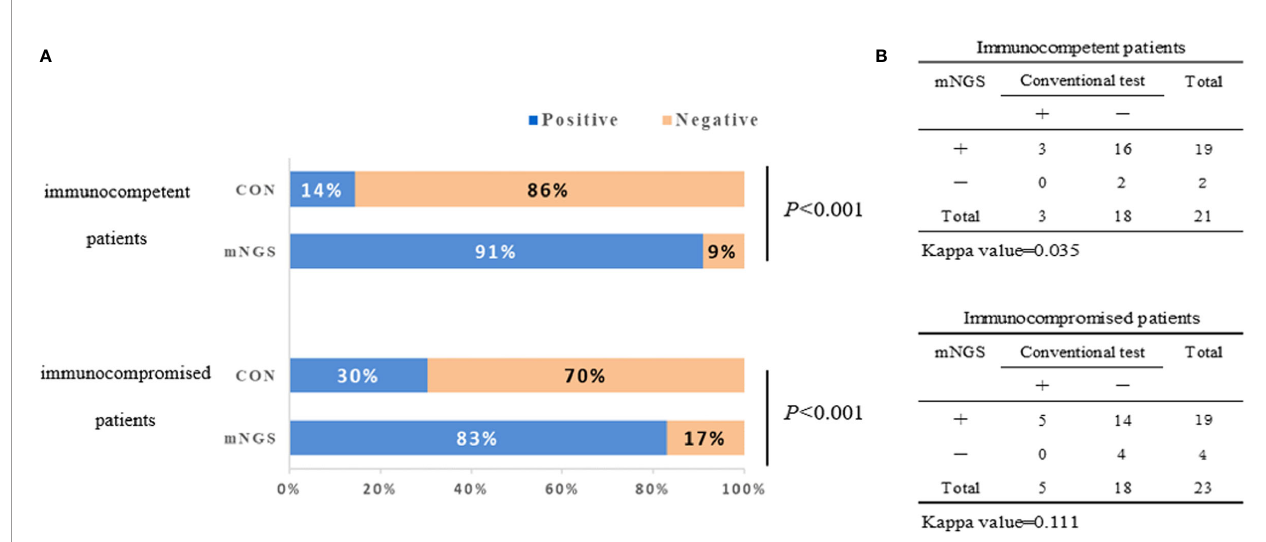
FIGURE 1 | The positivity rate comparison and concordance analysis between metagenomic next-generation sequencing (mNGS) and conventional test. (A) The comparisons of positive rates (X-axis) for pairwised mNGS and conventional test in immunocompetent patients and immunocompromised patients (Y-axis) ( P <0.001). (B) Concordance test showing there were low Kappa values of positive rates between mNGS and conventional test for both immunocompetent patients (0.035) and immunocompromised patients (0.111). mNGS, metagenomic next-generation sequencing; CON, conventional patients (56.5% vs. 42.9%, P =0.073, Figure 4 ). More than a half (13 of 23) SCAP patients in immunosuppressed group had reduced or downgraded antibiotic adjustments based on the results. After the availability of mNGS, the DOTs were also higher for immunocompromised than immunocompetent